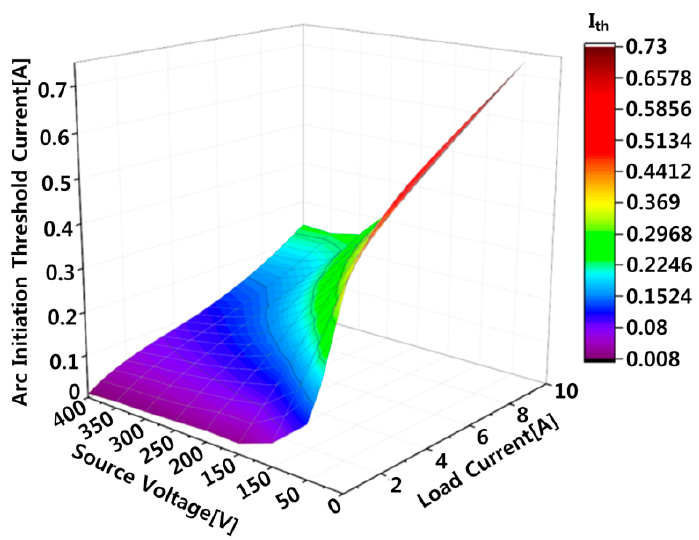
Figure 9. Characteristics of arc initiation threshold current as source voltage and load current.